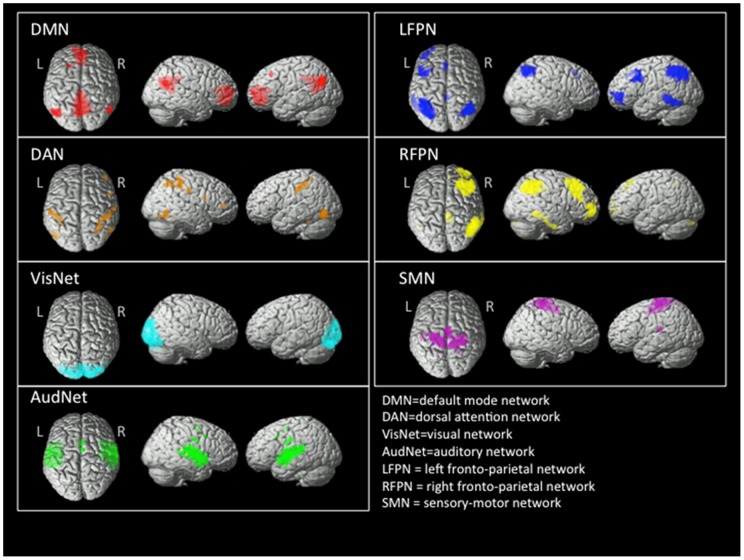
Three-dimensonal rendering of the resting state networks estimated by independent components analysis.The default mode network (DMN) has been linked to self-oriented mental activity; the dorsal-attention network (DAN) has been associated with goal-directed stimulus-response selection; The visual network (VisNet) has been associated with visual processing; the auditory network (AudNet) has been associated to processing of auditory stimuli; the left-lateralized fronto-parietal network (LFPN) and the right-lateralized fronto-parietal network (RFPN) have been associated to memory functions; the sensory-motor network (SMN) comprises primary sensory-motor areas and the supplementary motor area. For the correlation analysis, we selected the DMN, the DAN, and the SMN, based on anatomical considerations. See text for further details.